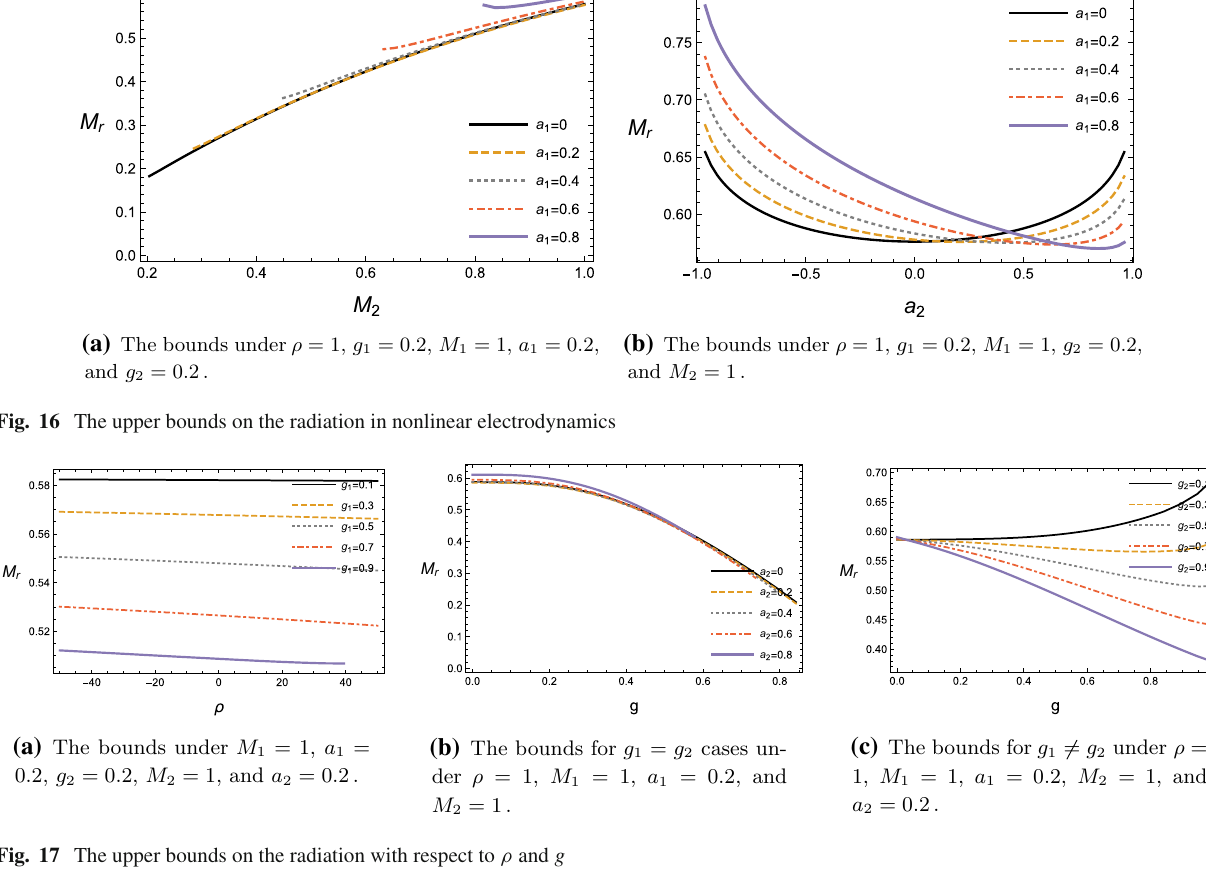
(c) The bounds for g 1 = g 2 under ρ = 1, M 1 = 1, a 1 = 0 . 2, M 2 = 1, and a 2 = 0 . 2.